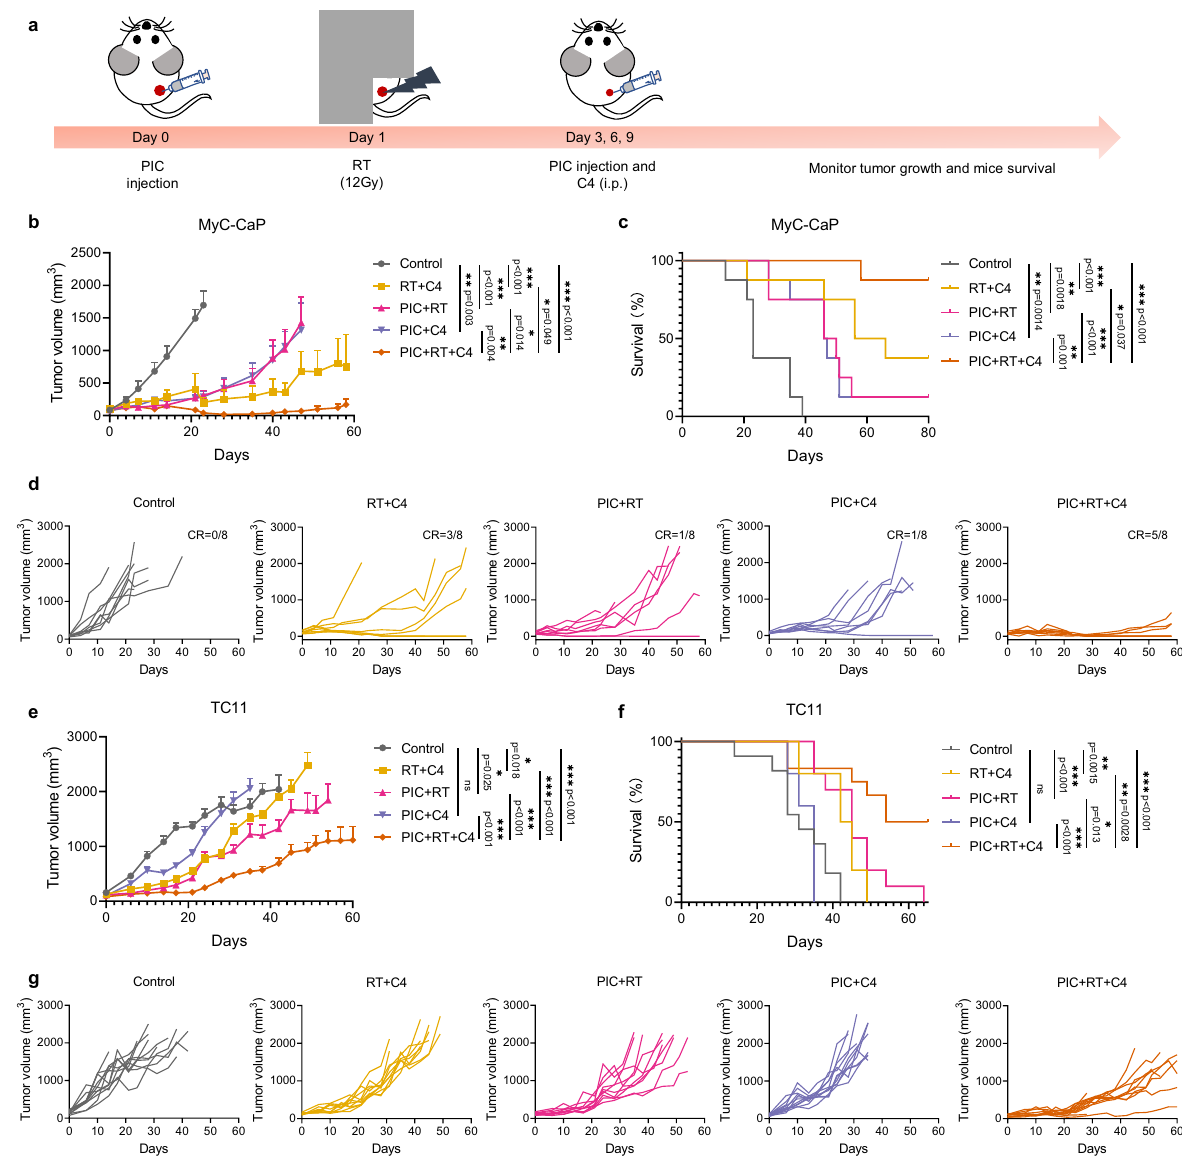
Fig. 6 | The combination of PIC+RT+anti-CTLA-4 (C4) improves tumor response and survival in both the MyC-CaP prostate and TC11 breast tumor models. a Scheme for the studies. b Average tumor growth curves of MyC-CaP prostate tumors and c survival rate of mice after the indicated treatments. ( n =8 biologically independent animals). d Individual tumor growth curves in b . e Average tumor growth curves of TC11 tumor and f survival rate of mice after the indicated treatments (control: n =11; PIC+RT+C4: n =12; others: n =10 biologi- cally independent animals). g Individual tumor growth curves in e . CR: complete